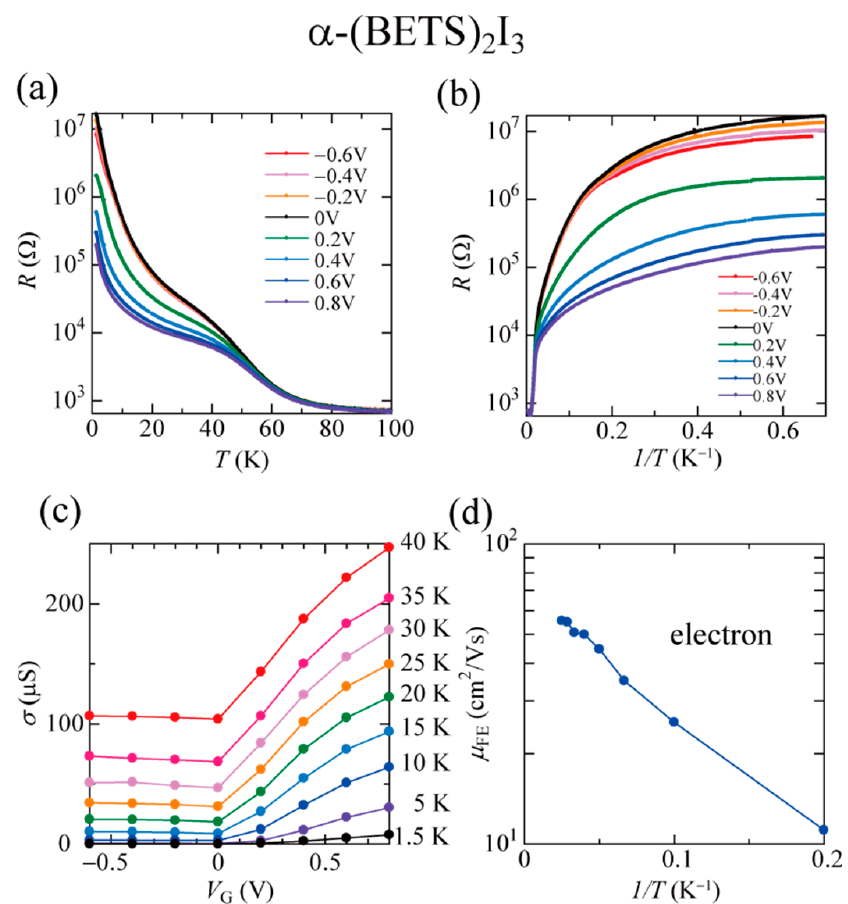
Figure 5. ( a ) Temperature dependence of the four-probe resistance at various gate voltages and ( b ) Arrhenius plots for α -(BETS) 2 I 3 . ( c ) Gate voltage dependence of the sheet conductivity at 1.5–40 K. ( d ) Arrhenius plots of the field-effect mobility estimated in the range of 0.2 V < V G < 0.4